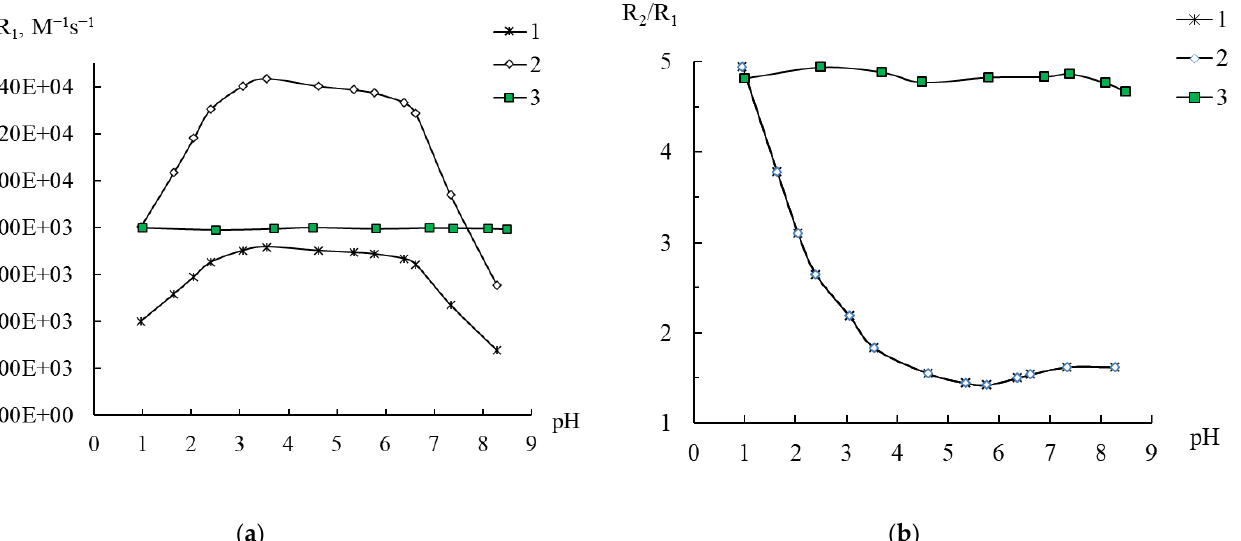
Figure 6. Dependence of the spin–lattice relaxivity R1 ( a ) and the ratio R 2 /R 1 ( b ) on pH in a 0.1 M solution of 3 in water. Calculations of relaxivity were carried out taking into account manganese(II) concentrations of 0.4 mM (1) and 0.2 mM (2). For comparison, data are presented for a MnCl 2 solution with a manganese(II) aqua ion content of 0.4 mM (3).